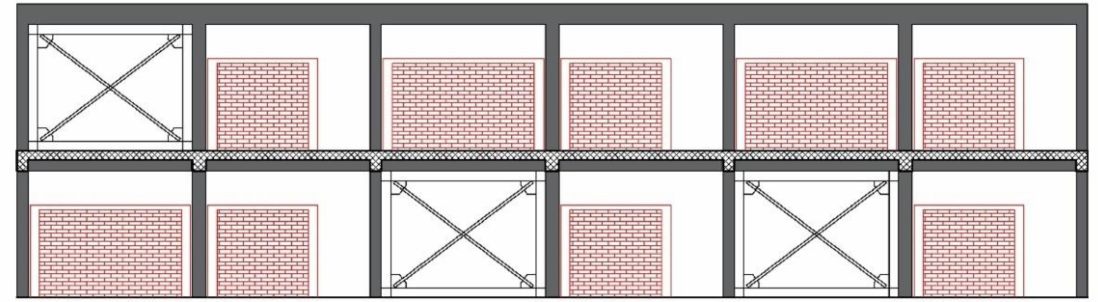
Figure 5. PREbuilding type: schematic view for the retrofitting intervention A 2 .